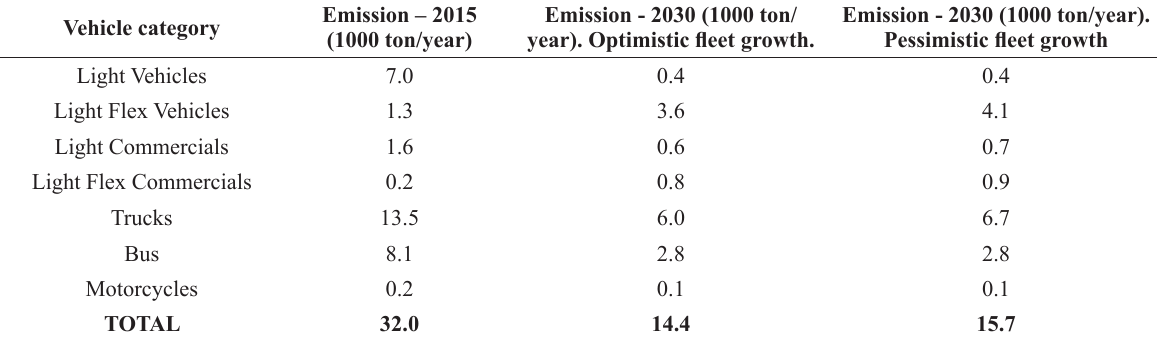
Total values of emission of the specie NO , linked with the vehicular activity in the MRPA, according to the pessimistic x and optimistic scenarios of the fleet for the years 2015 and